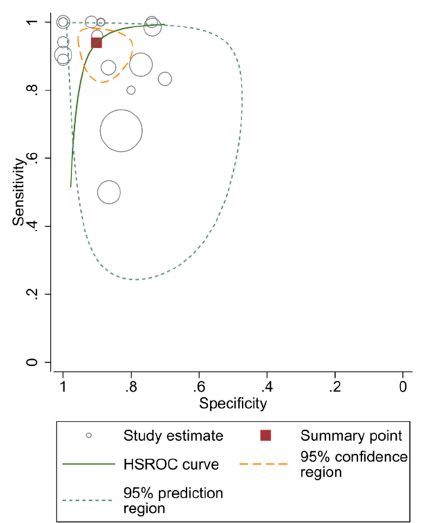
Figure 6. Hierarchical summary receiver operating characteristic (HSROC) curve of the diagnostic performance of the central vein sign in T2*-based images for differentiating MS from other mimicking diseases.